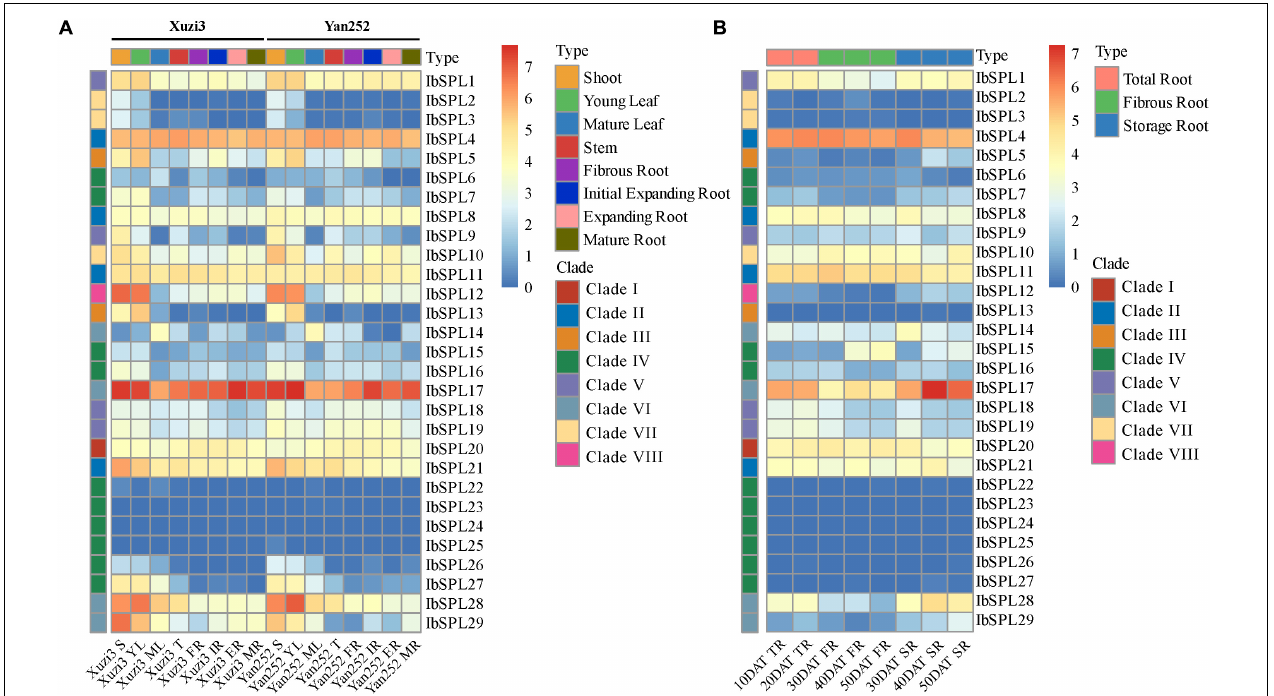
FIGURE 5 | Expression profiles of IbSPL genes in different tissues and developmental stages using transcriptome analysis. (A) Heatmap representing the expression patterns of IbSPL genes in eight different tissues of two sweet potato cultivars (Xuzi3 and Yan252). Xuzi3: sweet potato cultivar Xuzi3, Yan252: sweet potato cultivar Yan252, S: shoot, YL: young leaf, ML: mature leaf, T: stem, FR: fibrous root, IR: initial tuberous root, ER: expanding storage root, MR: mature storage root. (B) Heatmap representing the expression patterns of IbSPL genes in eight different stages of root development. 10DAT_TR: undifferentiated root (10 days after transplanting), 20DAT_TR: undifferentiated root (20 days after transplanting), 30DAT_FR: fibrous root (30 days after transplanting), 40DAT_FR: fibrous root (days after transplanting), 50DAT_FR: fibrous root (50 days after transplanting), 30DAT_SR: storage root (30 days after transplanting), 40DAT_SR: storage root (40 days after transplanting), 50DAT_SR: storage root (50 days after transplanting). Heatmaps were generated based on the log 2 (FPKM + 1) values for each IbSPL